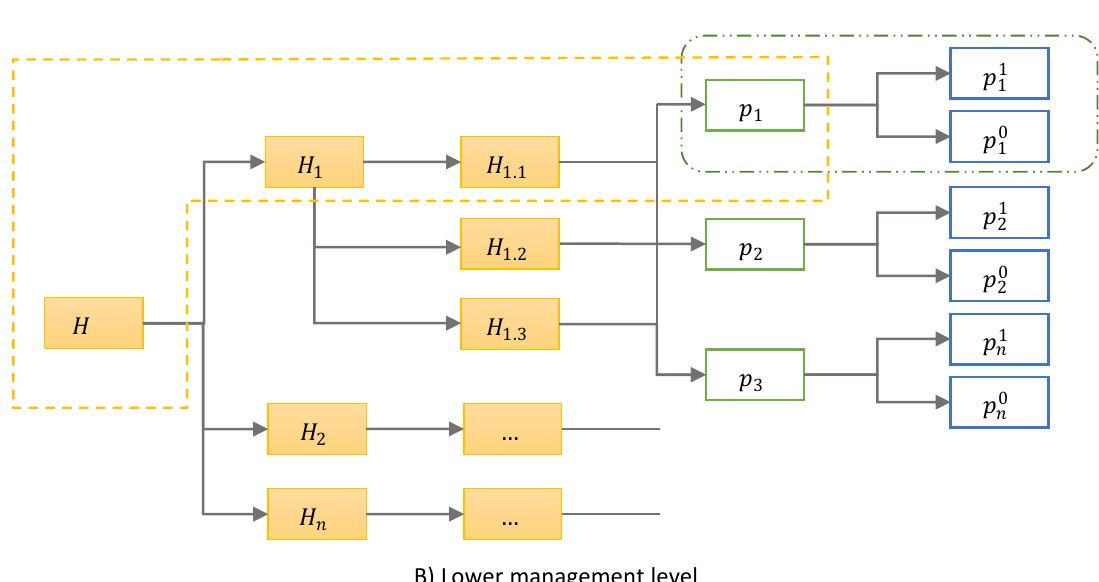
Figure 2. The fragment of the morphological graph of ODBMS at the middle and lower management